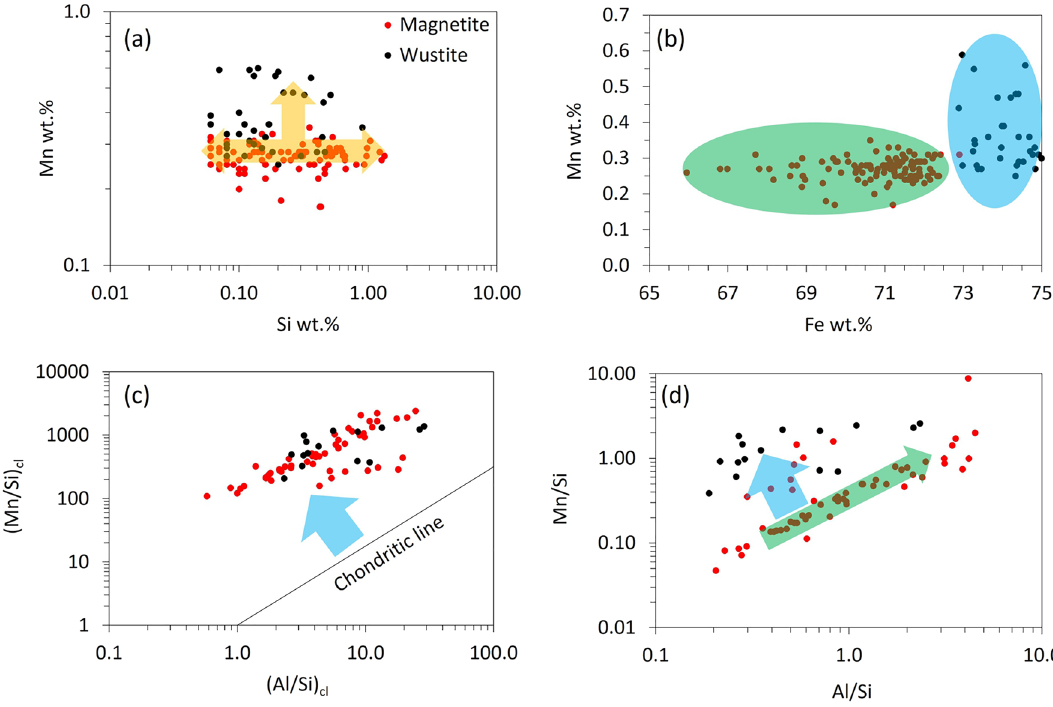
Figure 3. ( a ) Si versus Mn wt%, ( b ) Fe versus Mn wt%, ( c ) Al/Si cl versus Mn/Si cl , and ( d ) Al/Si versus Mn/Si, shows the magnetite (red) and wustite (black)